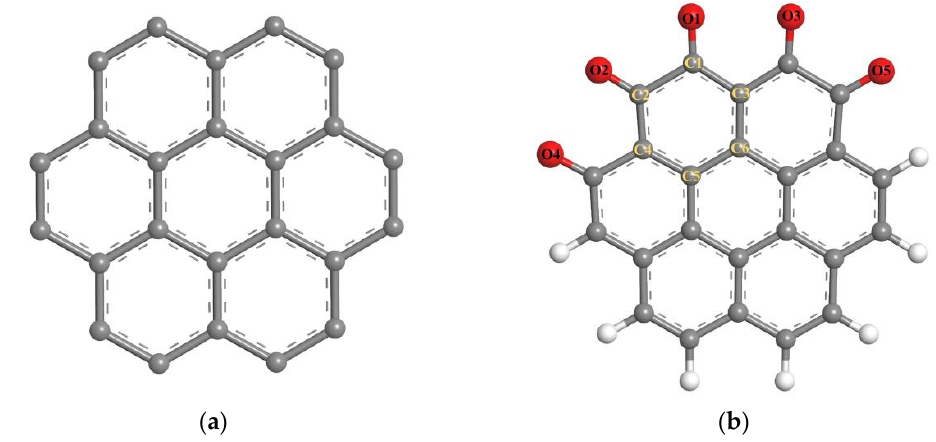
Figure 1. ( a ) Typical micro-structure in anode; ( b ) calculation Model